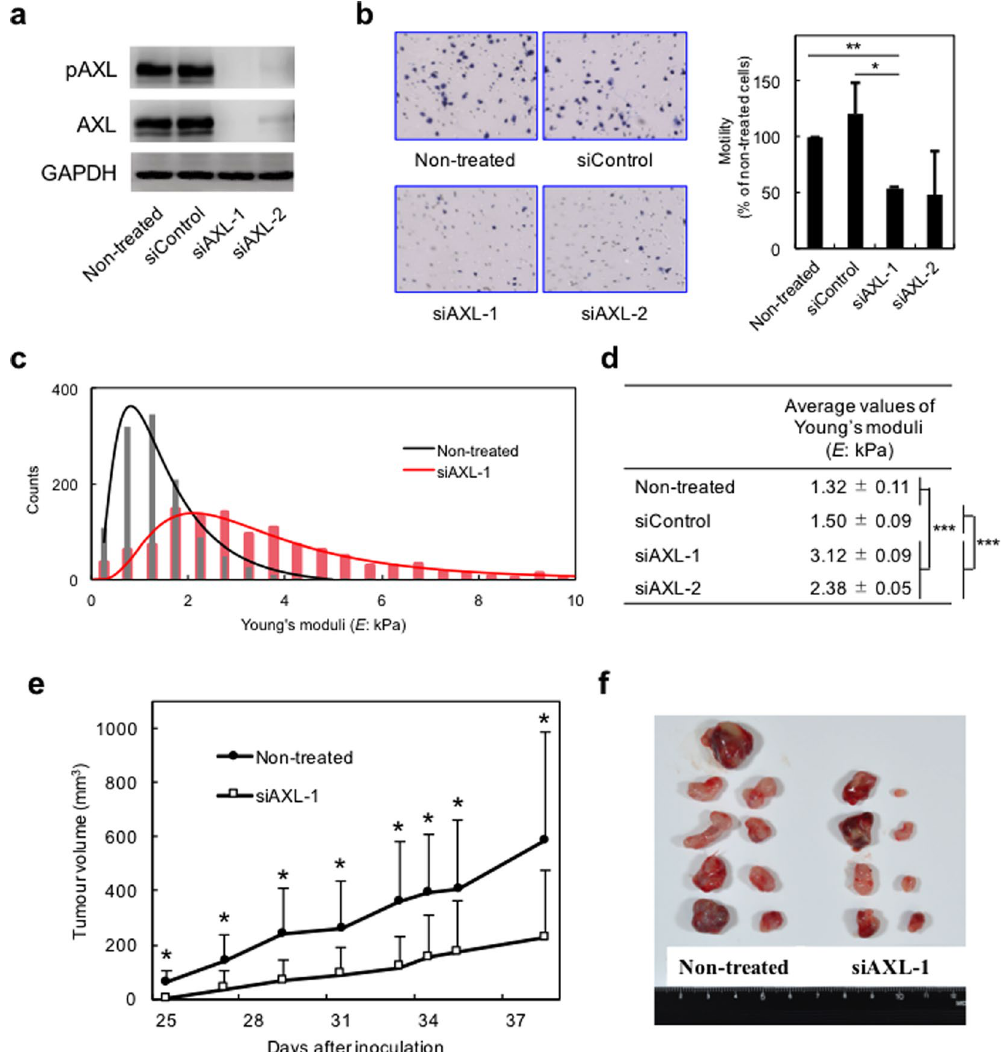
Figure 3. Knockdown of AXL inhibits motility and increases cell stiffness, resulting in inhibition of tumour formation in mouse xenograft model. ( a ) Western blot analysis of H1299 cells treated with medium alone, siControl, siAXL-1 or siAXL-2 for 48 h. The results were confirmed in three independent experiments. ( b ) Cell motility assays in cells transfected with the indicated siRNA. Left, representative images of migrated cells attached to membranes. Right, average percent of migrated cells in three independent experiments. Mean ± s.d. Number of migrated cells in non-treated cells was set as 100%. * p < 0.05, ** p < 0.01. ( c ) Young’s moduli of 76–82 cells transfected with siAXL-1 for 48 h were determined using AFM. Black line indicates the log-normal fitting curve for non-treated cells, and the red line indicates the curve for siAXL-1-transfected cells. ( d ) Average values of Young’s moduli were obtained from log-normal fitting curves. *** p < 0.001. ( e ) Tumour volume in a mouse xenograft model of mice implanted with siAXL-1-transfected cells compared with mice with non-treated cells (n = 5 in each group). Tumours were measured every 2 or 3 days. Data represent the average tumour volume and standard deviation. * p < 0.05. ( f ) Image of tumours at the end of the